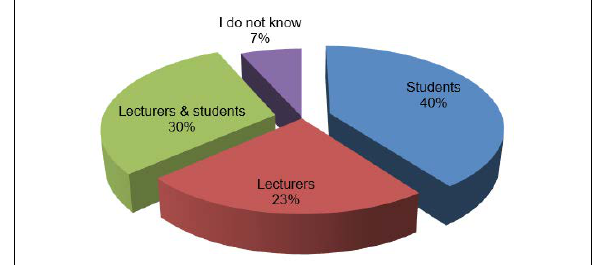
Respondents’ perceptions on who initiates sexually transmitted marks: lecturer or student.